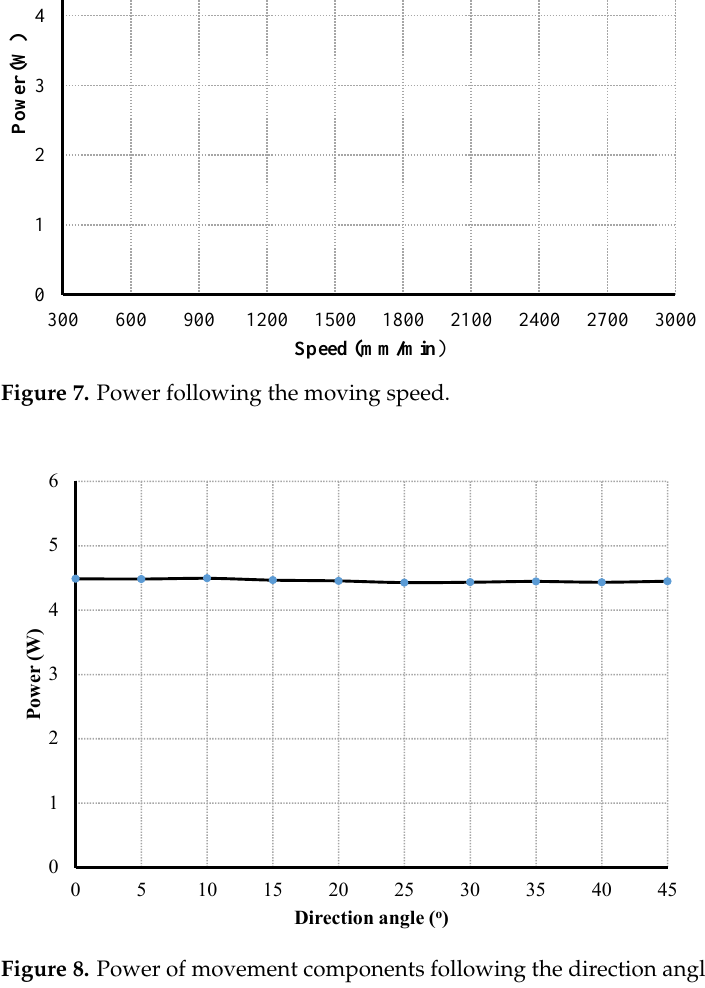
Figure 8. Power of movement components following the direction